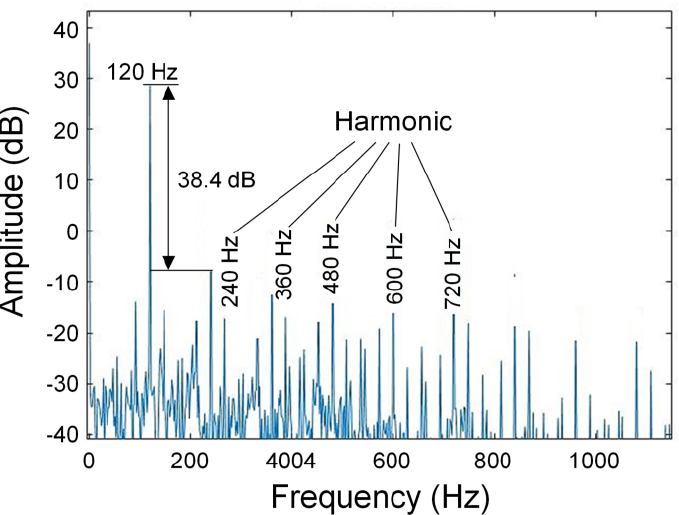
Figure 12. Sensitivity curves at different acoustic frequencies.